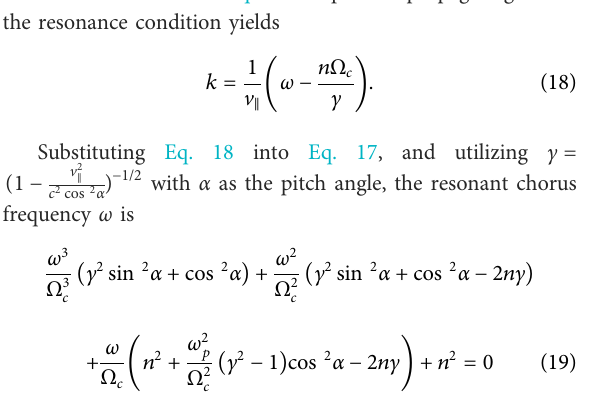
J 0 / 90 between the two